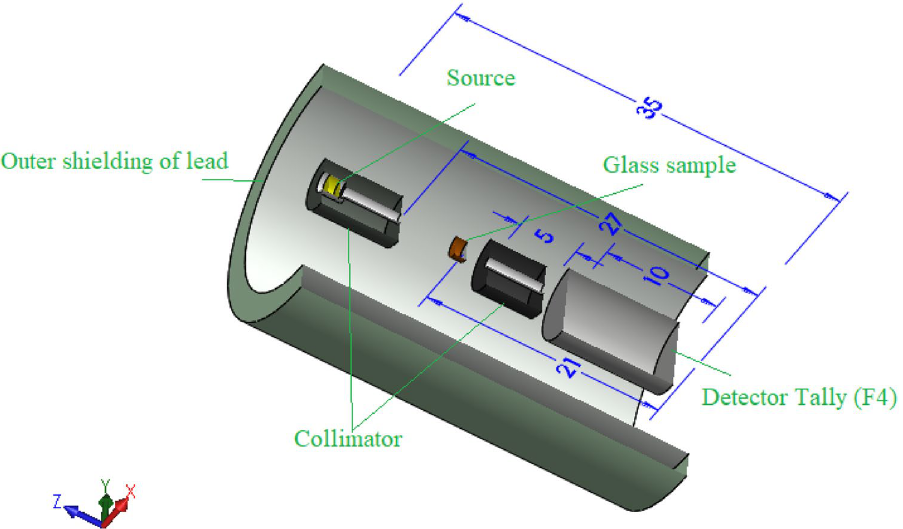
Figure 1. A 3D representation for the MC geometry